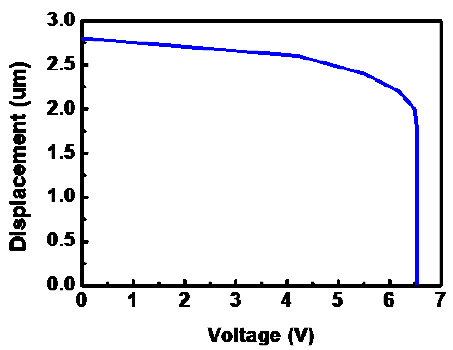
Figure 3. Displacement versus actuation